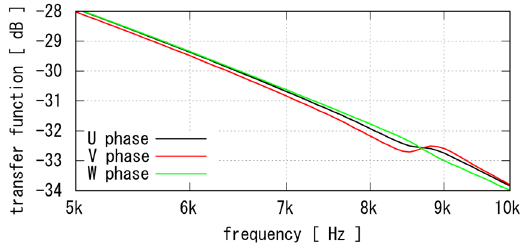
Figure 8. Effect of stabilizing winding on RBS (TFs of Tr-A4b).